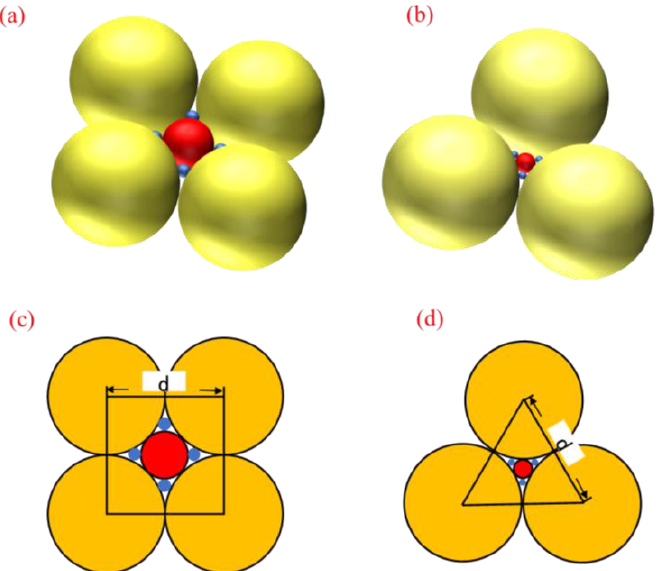
Figure 6. Two basic patterns of particle distribution: ( a ) cubic stacking stereogram; ( b ) hexagonal densest stacking stereogram; ( c ) cubic stacking plane graph; ( d ) hexagonal densest stacking plane graph.